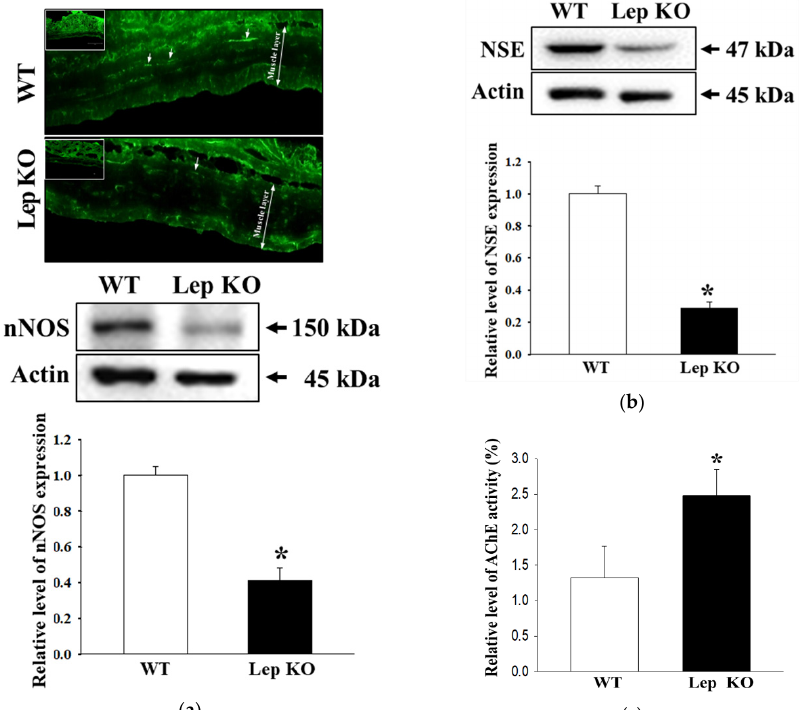
Figure 6. Expression of nNOS and NSE, and AChE activity. ( a ) The tissue distribution of nNOS was detected in the transverse colon using immunofluorescence (IF) staining assay. Three to five mice per group were used in the slide section, and IF staining was assessed in duplicate in two different slides. The expression levels of nNOS were measured by Western blot analysis using the specific primary antibodies and HRP-labeled anti-rabbit IgG antibody. Three to five mice per group were used to prepare the total tissue homogenate, and Western blot analyses were assayed in duplicate in each sample; ( b ) The expression levels of NSE were measured by Western blot analysis using the specific primary antibodies and HRP-labeled anti-rabbit IgG antibody. Three to five mice per group were used to prepare the total tissue homogenate, and Western blot analyses were assayed in duplicate in each sample; ( c ) After homogenizing the transverse colon tissue, the AChE activity was measured using an Acetylcholinesterase Assay Kit that could detect as little as 0.01 mU AChE in a 100 µ L assay volume (0.1 mU / mL). Three to five mice per group were used to prepare the tissue lysate, and enzyme activity was assayed in duplicate in each test. The data are reported as the mean ± SD. *, p < 0.05 compared to the WT group. Abbreviations: WT, Wild type; KO, Knockout type; nNOS, Neuronal nitric oxide synthase; NSE, Neuron-specific enolase; AChE,